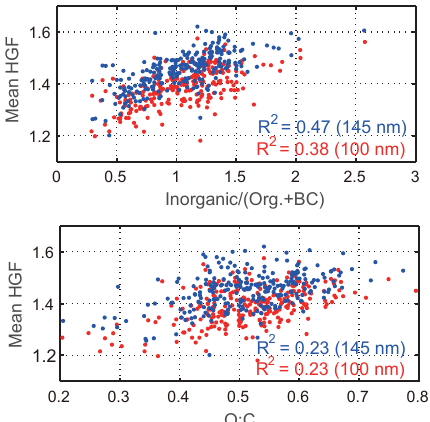
Figure 5. Diurnal variation of mass concentration of SO 2 − ics, NO − , BC in particle phase, and the O : C ratio of organics 3 and their relative contributions in particle-phase composition dur- ing clean days and polluted